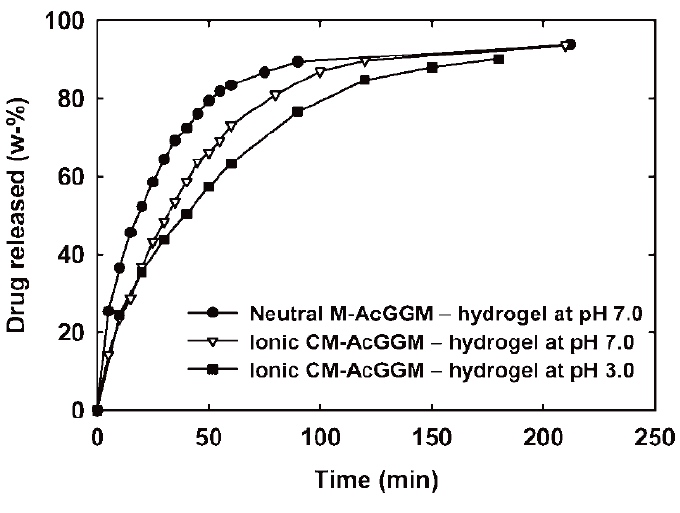
O, 37 °C, 50 rpm stirring) from initially 2